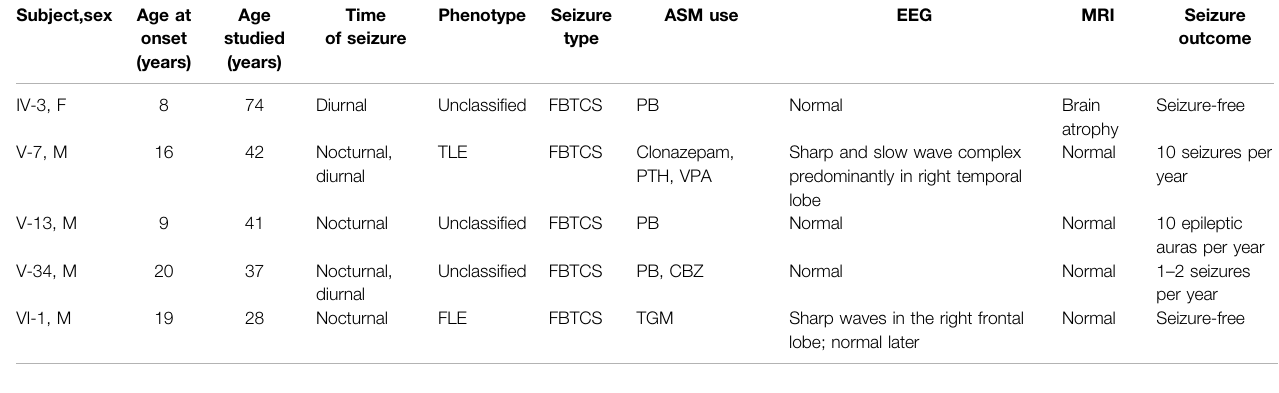
TABLE 1 | Clinical features of the patients in the FFEVF family.